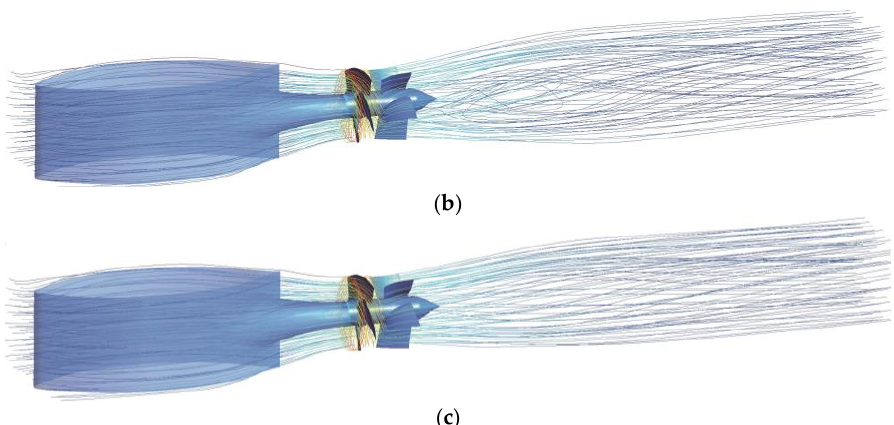
Figure 14. Three-dimensional streamlines of pump device: ( a ) Q = 0.8 Q bep ; ( b ) Q = 1.0 Q bep ; ( c ) Q = 1.2 Q bep .